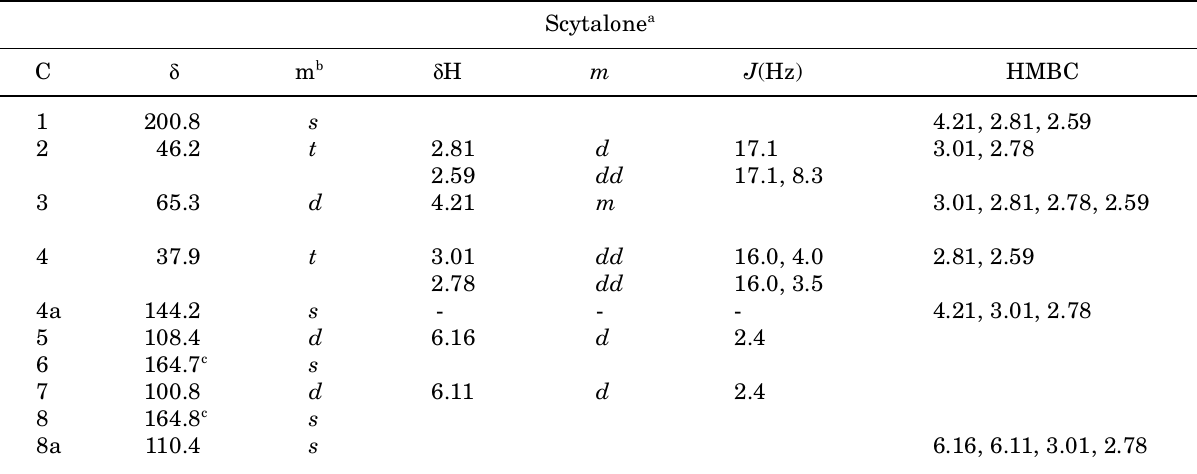
/CD OD, 99/1) for scytalone. 3 3